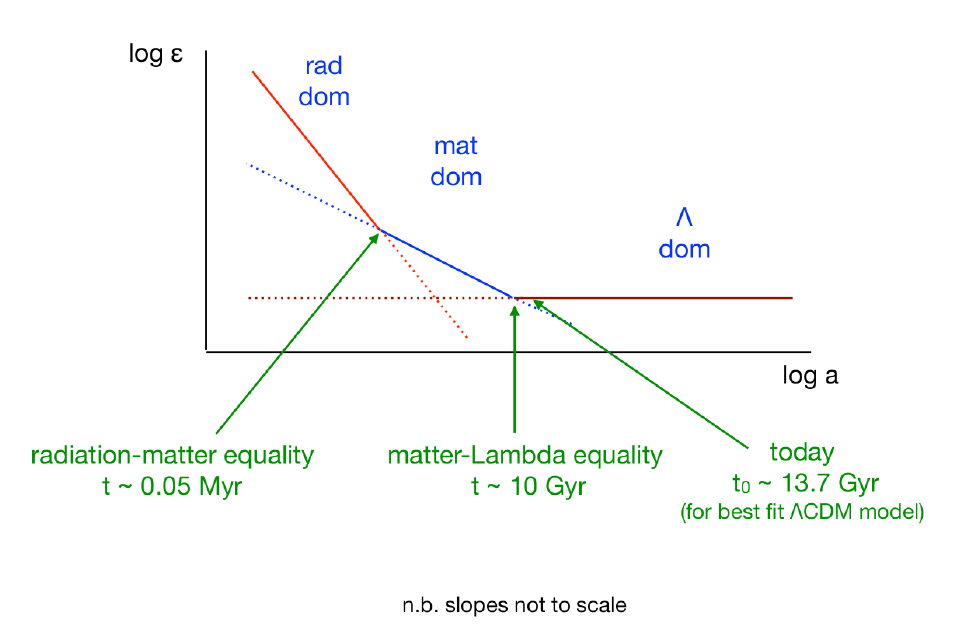
Figure 1: Evolution of the log of the density of the universe, ε , with the log of the scale factor, a . The universe starts off radiation dominated (red line), becomes matter dominated (blue) and then at late times is dominated by the cosmological constant